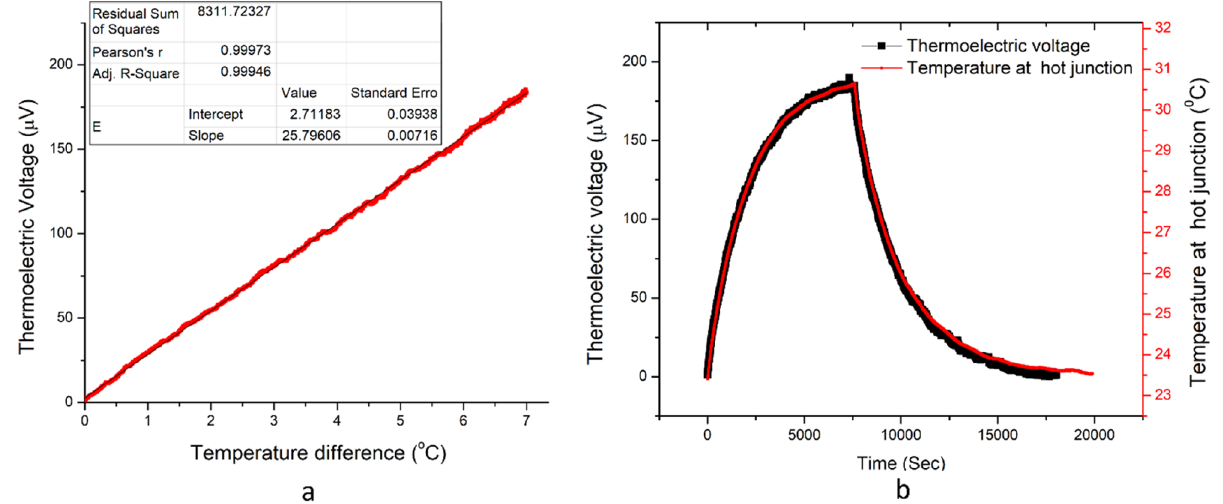
Figure 6. Temperature induced thermoelectric voltage in the sensor is plotted ( a ), Sensor applied for measuring the heating and cooling of heater coil shown with the proposed sensor and commercial thermocouple ( b ).